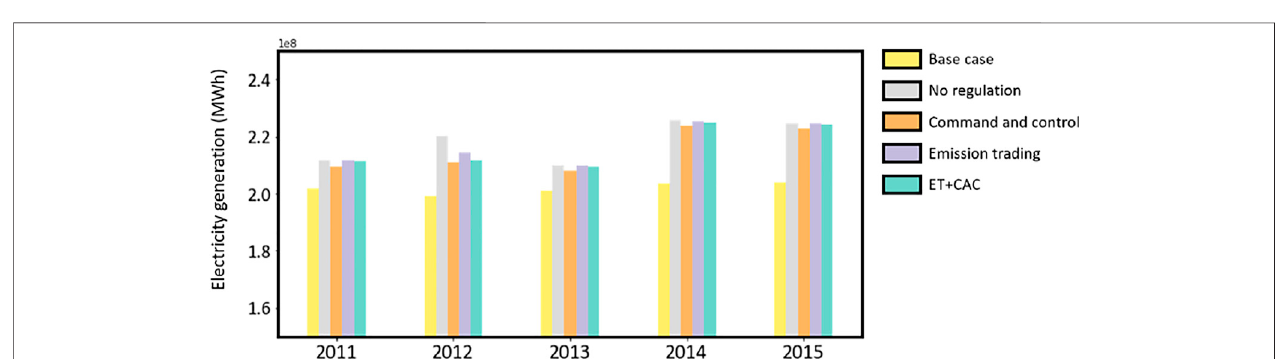
FIGURE 1 | Total electricity generation of Korean coal- fi red power plants under different emission regulation scenarios. The base case scenario represents real electricity generation for power plants; the no regulation scenario stands for eliminating technical ef fi ciency for power plants without emission regulation; the command and control scenario represents a scenario where technical ef fi ciency is eliminated but emissions must be restricted to the current level; the emission trading scenario stands for the case where overall emissions of all power plants are restricted to the current level but emissions are tradable; and ET + CAC refers to the scenario where emission trading and command-and-control are implemented in